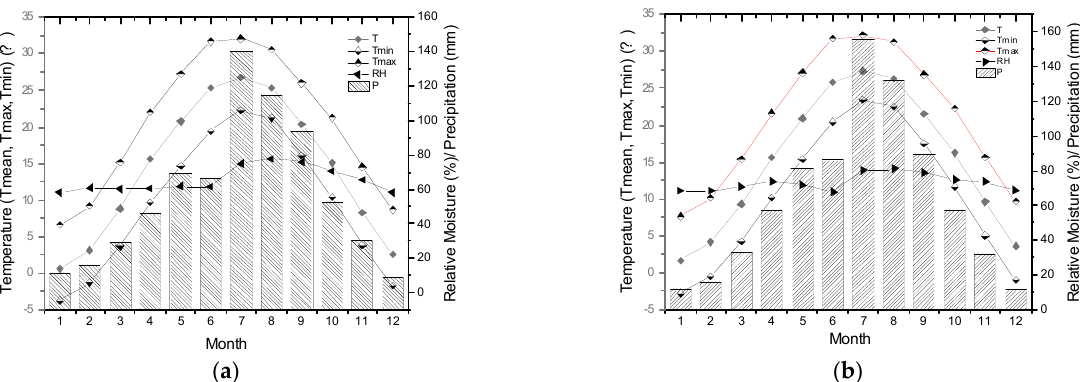
Figure 2. Average annual values of Tmax, T, Tmin, P and RH from Songxian ( a ) and Neixiang ( b ) meteorological stations during 1963–2016. Table 1. Characteristics of climate data used in correlation analyses. Climate Data Source